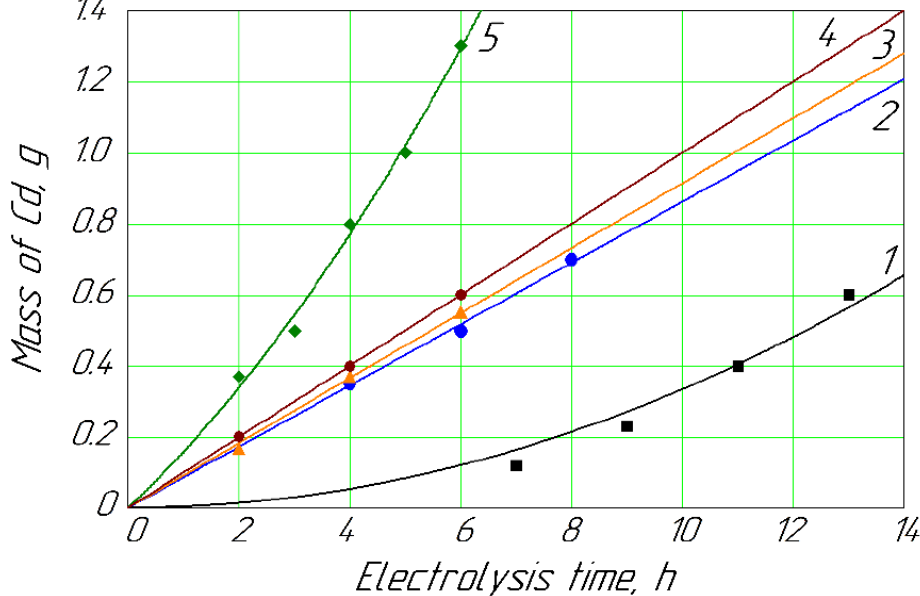
Figure 2. Mass of Cd deposited on the cathode vs. time for different concentrations of Cd 2+ in anolyte: 1, 0.013 mol/L; 2, 0.018 mol/L; 3, 0.022 mol/L; 4, 0.027 mol/L; 5, 0.089 mol/L.